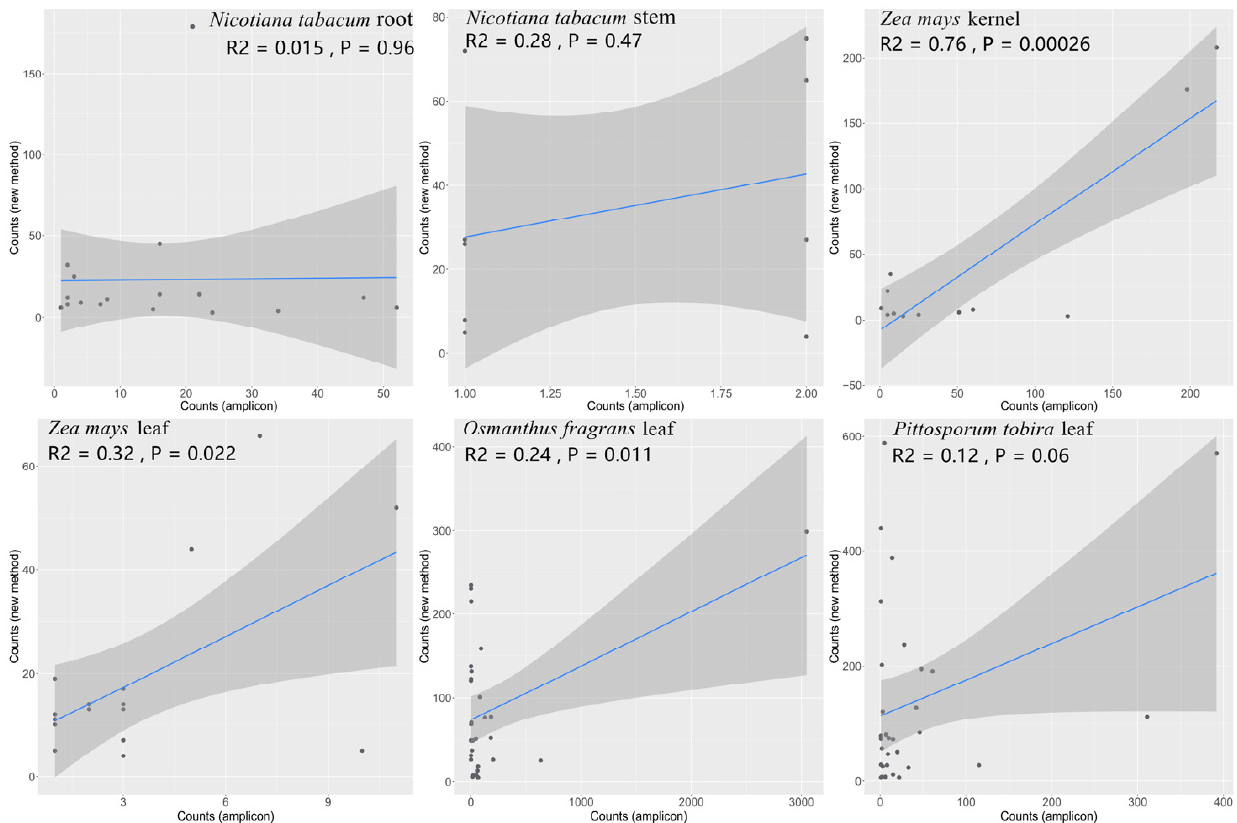
Figure 6. Scatter plot of the relevance of microbial information with different methods.